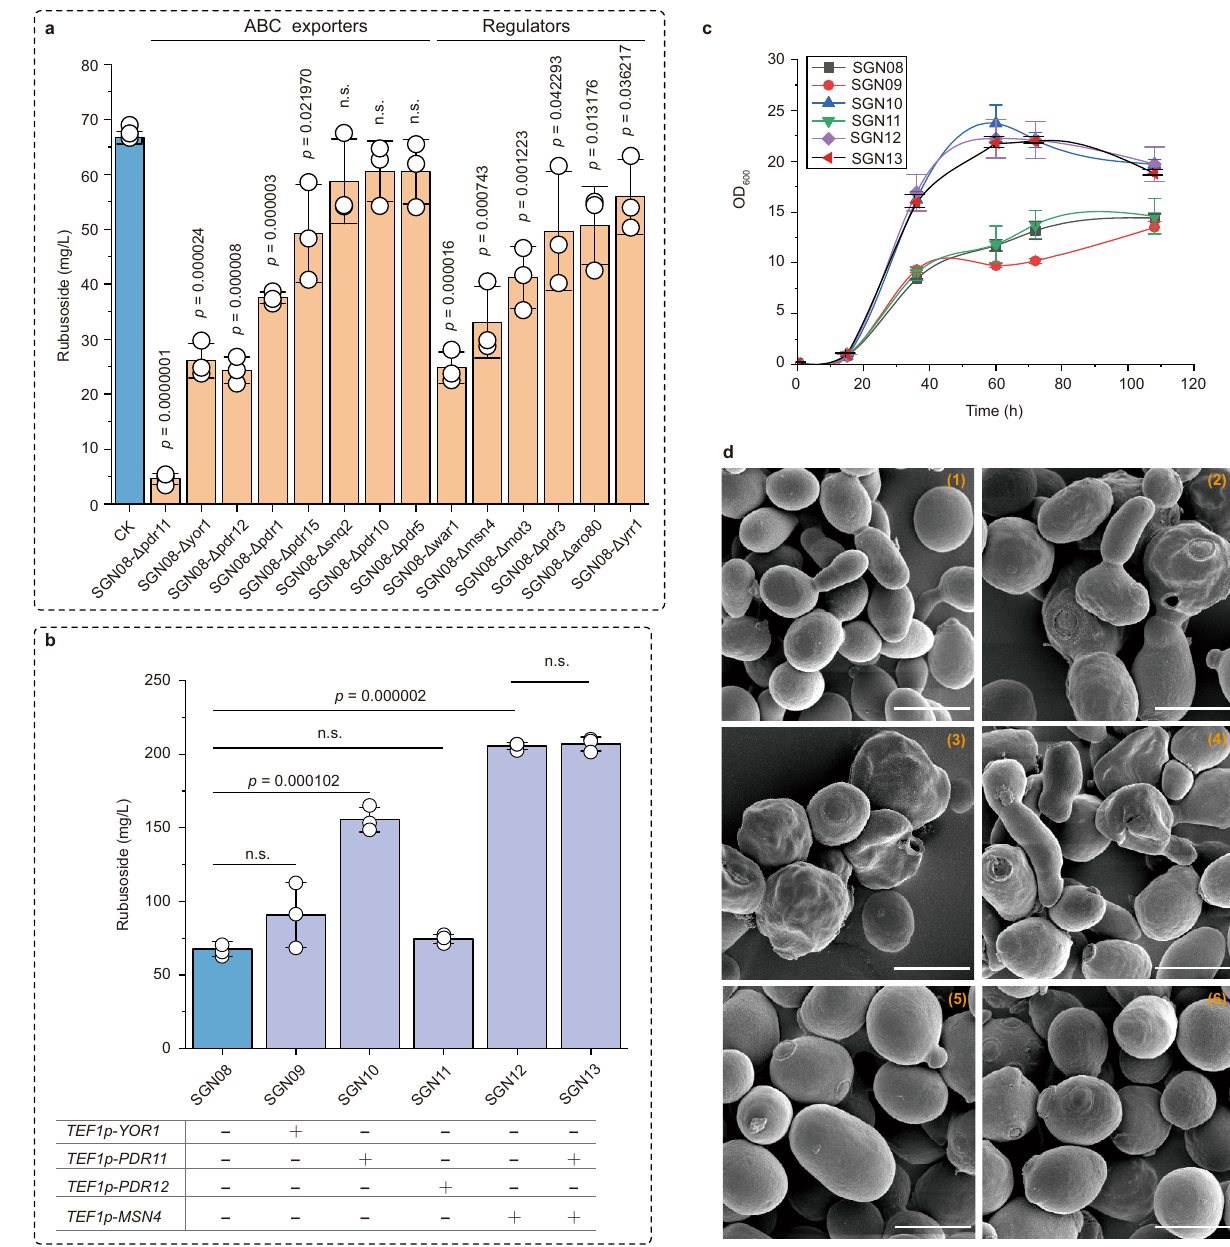
Fig. 3 Improvement of the yeast adaptation to rubusoside. a Changes of rubusoside titer after deleting the ABC exporters in the PM and the pressure response regulators. Cells were cultured for 108 h; CK presents SGN08. b Changes of the rubusoside production in the ABC transporter and the pressure responsive factor MSN4 overexpression strains. CK presents the strain SGN08. c The biomass of the ABC transporter and the pressure responsive factor MSN4 overexpressed strains. d FESEM pictures of the yeast samples. (1). the original strain S. cerevisiae CEN.PK2-1C; (2). the strain SGN08; (3). the strain SGN08- Δ pdr11; (4). the strain SGN08- Δ msn4. (5). the strain SGN10 (overexpressed the ABC transporter PDR11); (6). the strain of SGN12 (overexpressed stress-respond regulator MSN4 ). Strains were cultivated in shake- fl ask, and cells were collected after fermentation 72 h. Bar = 5 μ m. a – c Data are presented as mean values ± SD from three independent biological replicates ( n = 3). a , b The circles represent individual data points. Signi fi cance ( p -value) was evaluated by two-sided t -test, n.s. presents p > 0.05. SGN08- Δ mot3 (41.2 mg/L), 27.2% in SGN08- Δ pdr3 (49.6 mg/L), to the WAR1 deletion phenotype. Interestingly, transcription levels 25.7% in SGN08- Δ aro80 (50.6 mg/L), and 18.0% in SGN08- Δ yrr1 of MSN4 raised with the increase in rubusoside content (55.9 mg/L) (Fig. 3a). This suggests that WAR1 and MSN4 may be (Supplementary Fig. 14, Supplementary Fig. 15). When MSN4 involved in the adaptation increase to rubusoside. However, was overexpressed using the plasmid pY16- TEF1p in the strain because WAR1 induces the transcription of the transporter SGN08, the rubusoside titer increased by 2.0-fold to 205.5 mg/L PDR12 , the rubusoside titer when WAR1 was deleted (24.8 mg/L) (SGN12, Fig. 3b). As in SGN10, the cell morphology of SGN12 also was similar to that of SGN08- Δ pdr12 (24.3 mg/L) (Fig. 3a), reverted to normal (Fig. 3d, Supplementary Fig. 16), and biomass suggesting that the change in PDR12 levels is the major contributor formation was greatly improved (Fig. 3c).